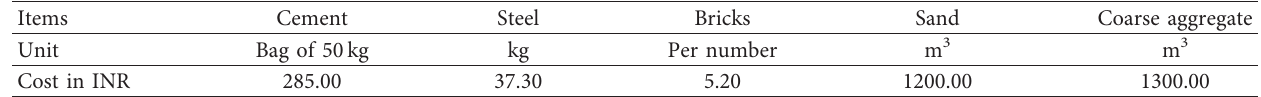
Table 3: Cost of common construction materials [50].